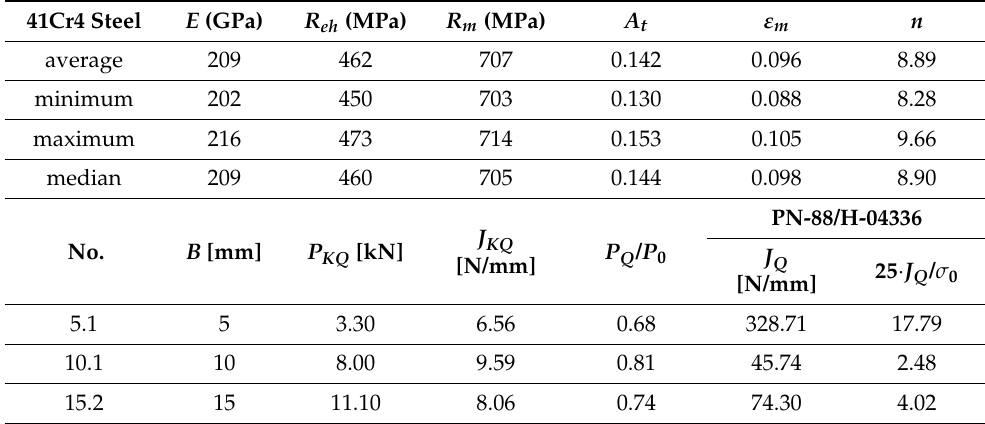
Table 1. Summary of selected uniaxial tensile test results and J C fracture toughness tests for 41Cr4 steel based on